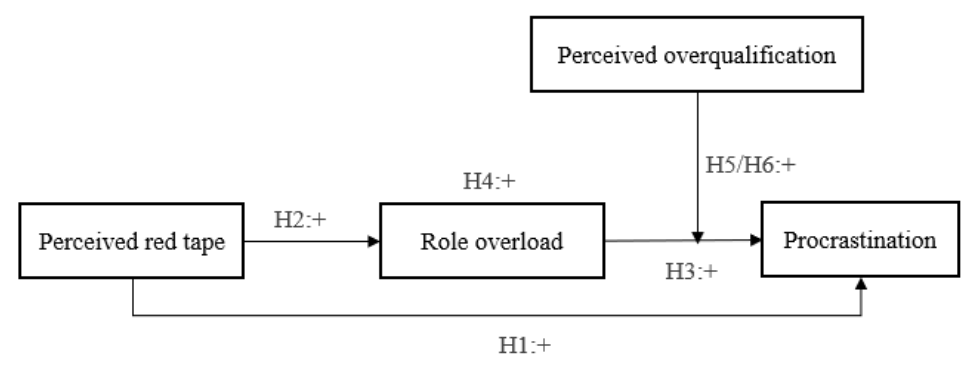
Figure 1. The theoretical framework of the study.